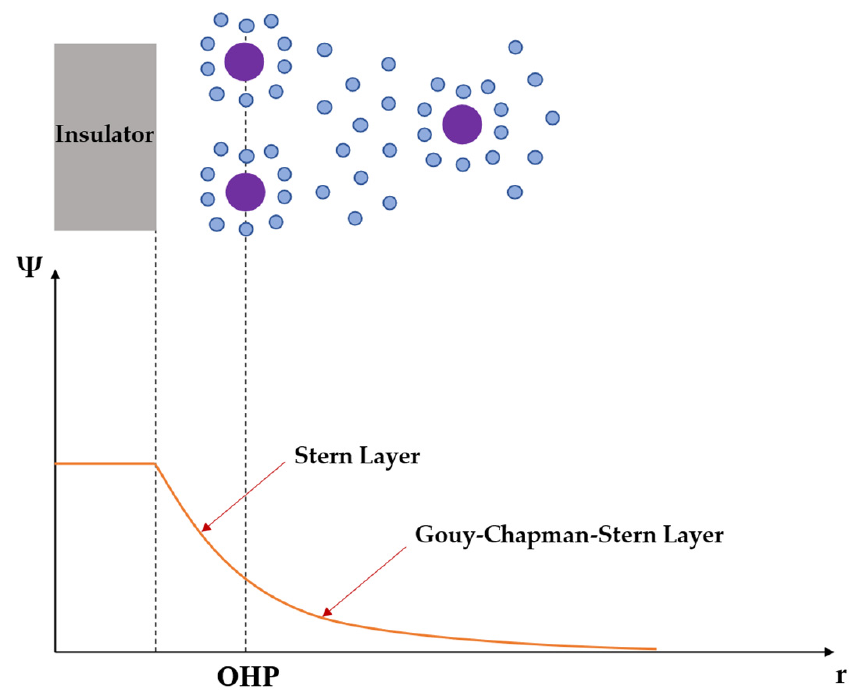
Figure 2. Illustration of the Stern layer.